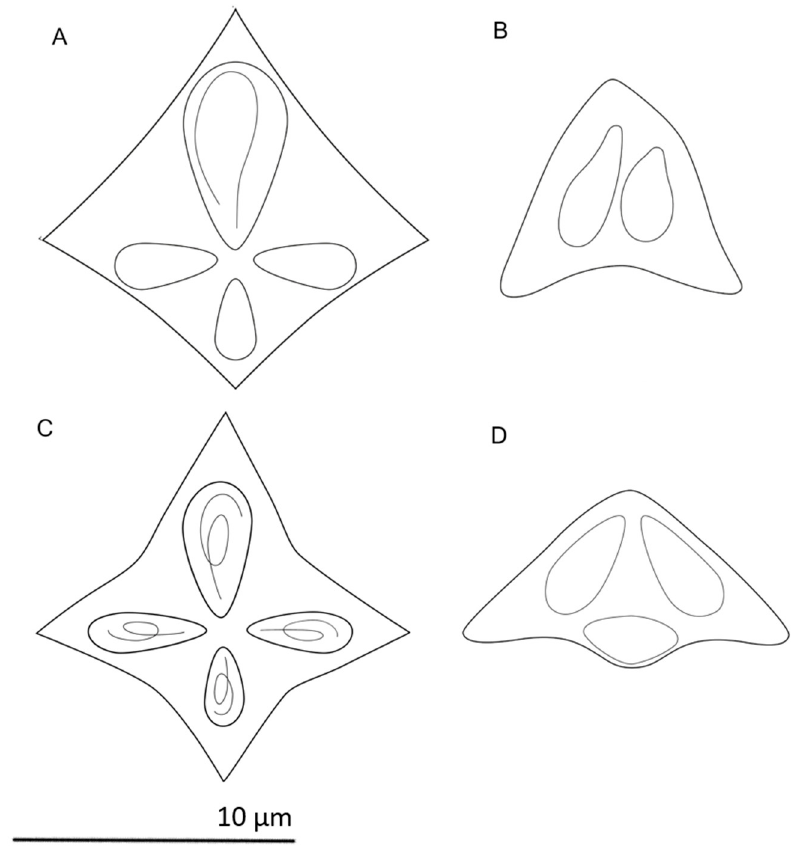
Figure 1. Line drawing of two Kudoa spp. in apical and lateral view. ( A , B ) K. mirabilis in Trichiurus lepturus from Tanzanian waters, ( C , D ) K. thyrsites in Thyrsites atun off the coast of Namibia.